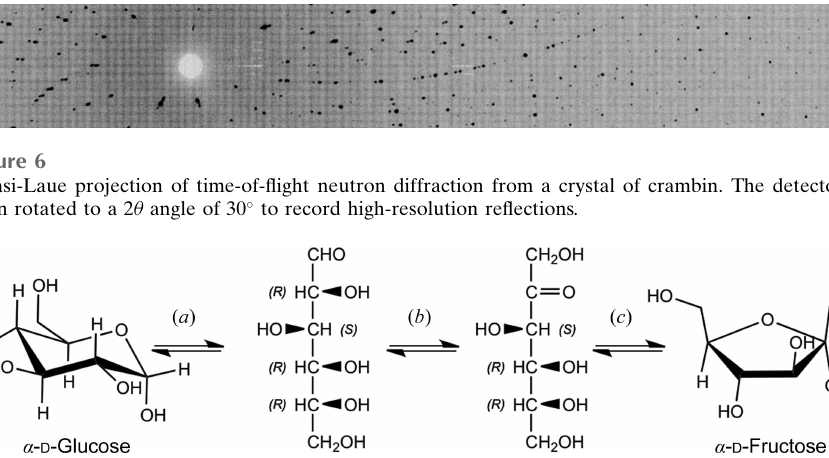
Figure 7 Mechanistic pathway for the isomerization of d -glucose to d -fructose, catalyzed by XI, with ring opening ( a ) followed by isomerization ( b ) and ring closing ( c ) (Kovalevsky et al. , 2010).